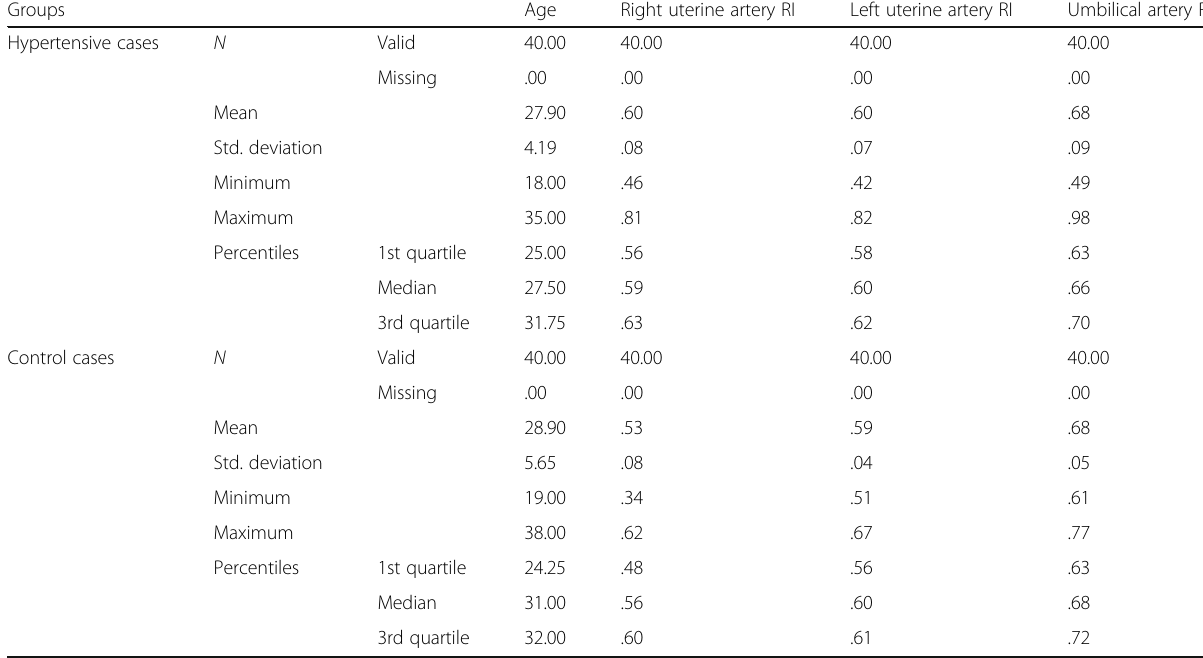
Table 2 Analysis of the RI of the right, the left uterine, and the umbilical arteries in the included cases Groups Age Right uterine artery